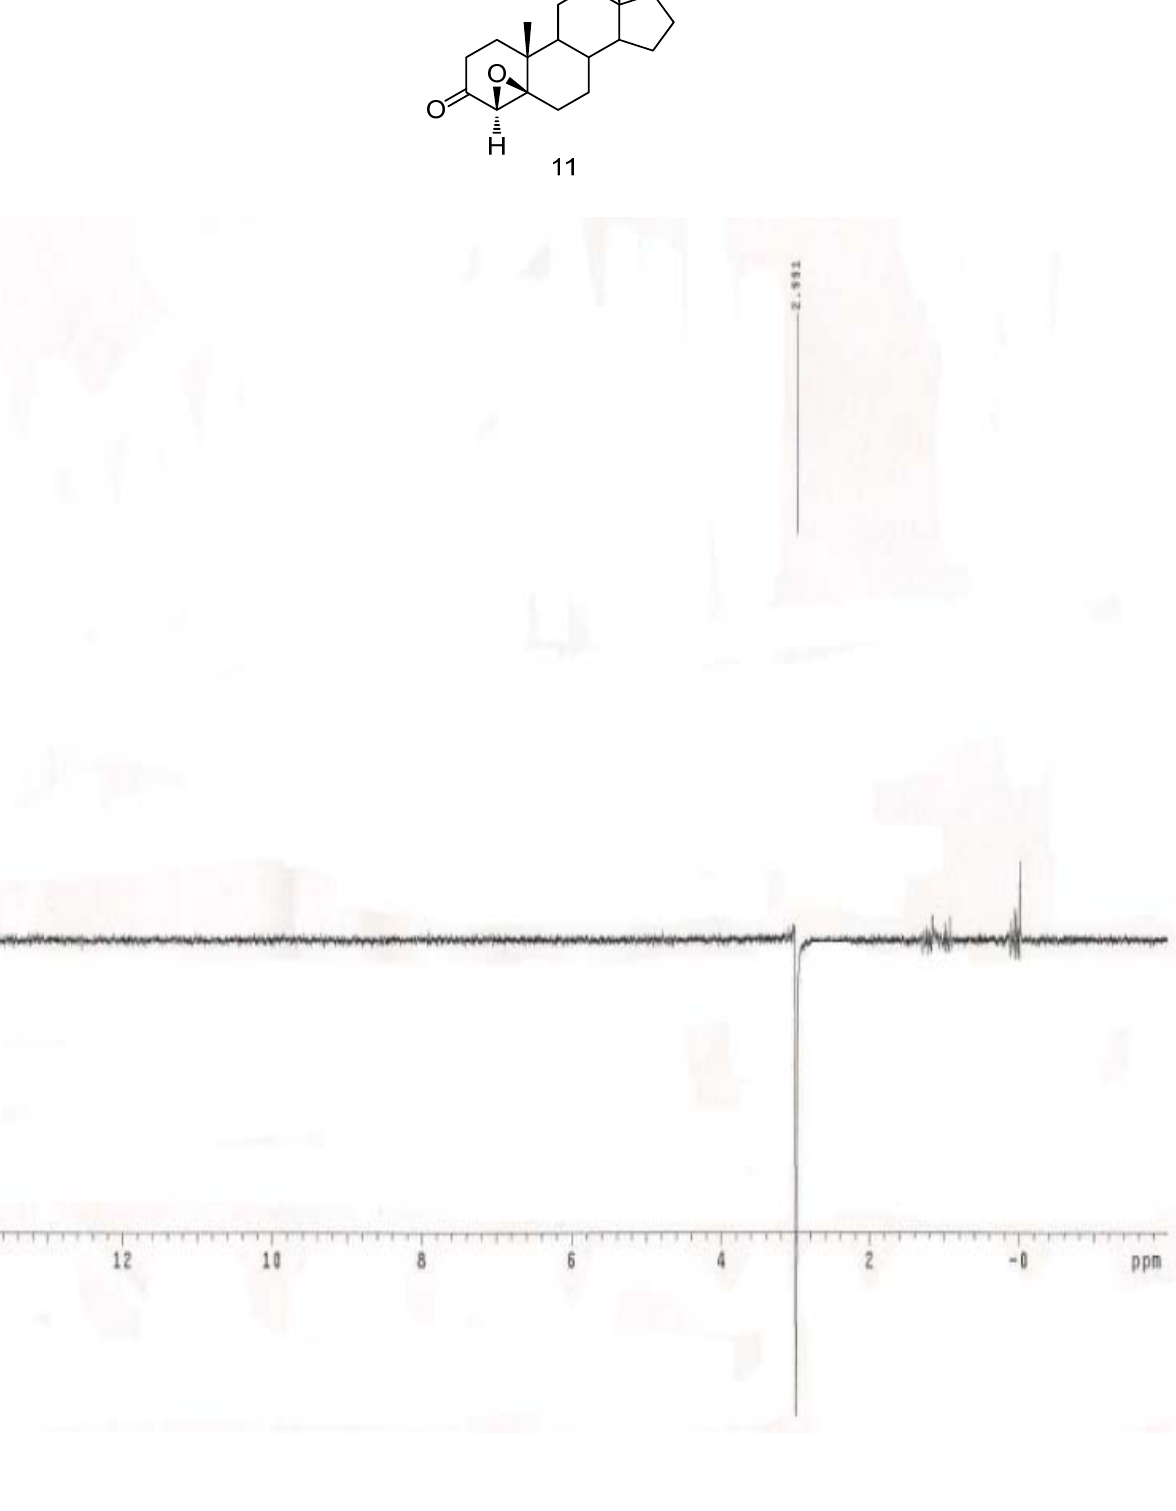
Figure 4. 1D-NOESY spectrum of 4 α -H with 19 β -CH